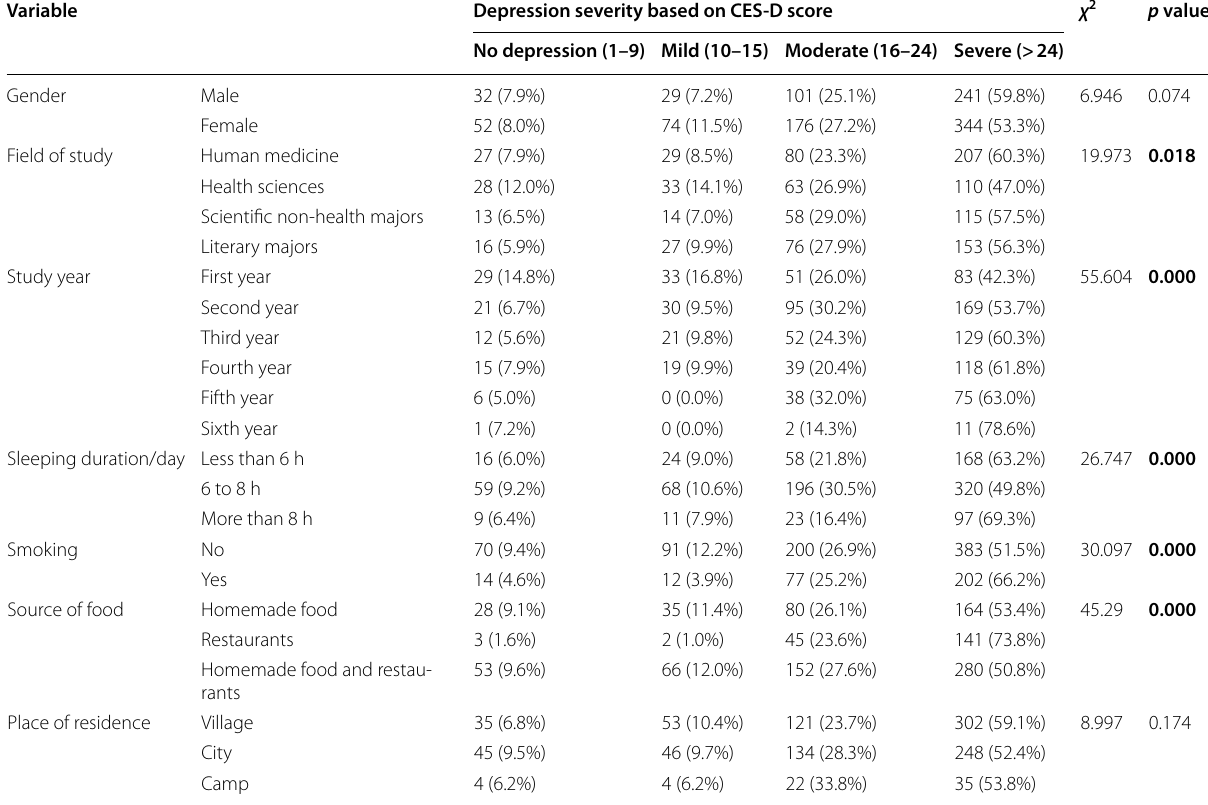
Table 3 The association between depression severity and sample characteristics ( n